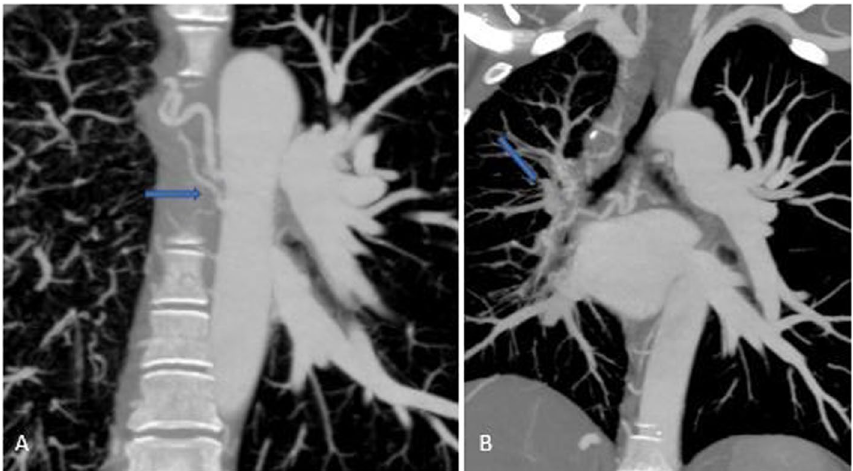
Fig. 4 CT Angiography MIP images coronal view (A, B) showing dilated and tortuous right bronchial arteries arising from the aorta (marked by the blue